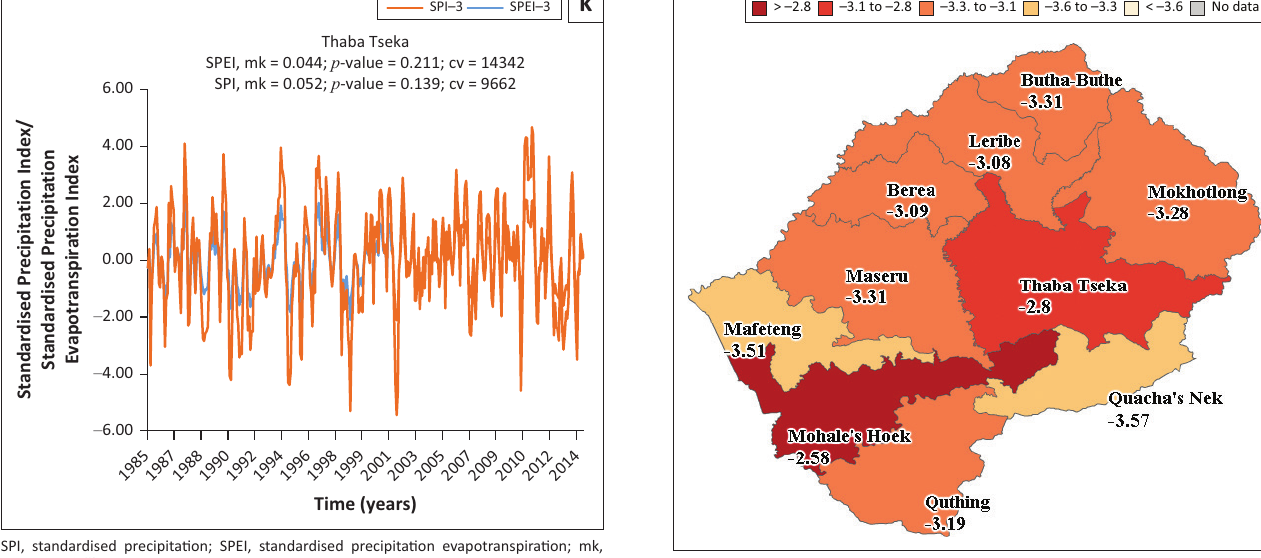
FIGURE 3: Dry spell spatiotemporal standardised precipitation-3 intensity maps (1985–2014). FIGURE 2 (Continues...): Standardised precipitation/standardised precipitation